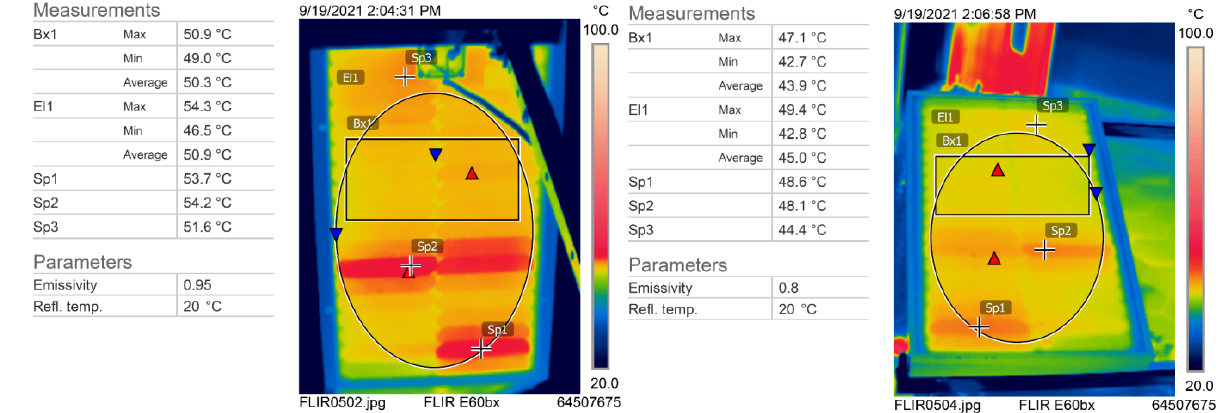
Figure 8. Pilot module thermogram recorded by the FLIR E60bx camera: bottom side ( left ), top side ( right ).